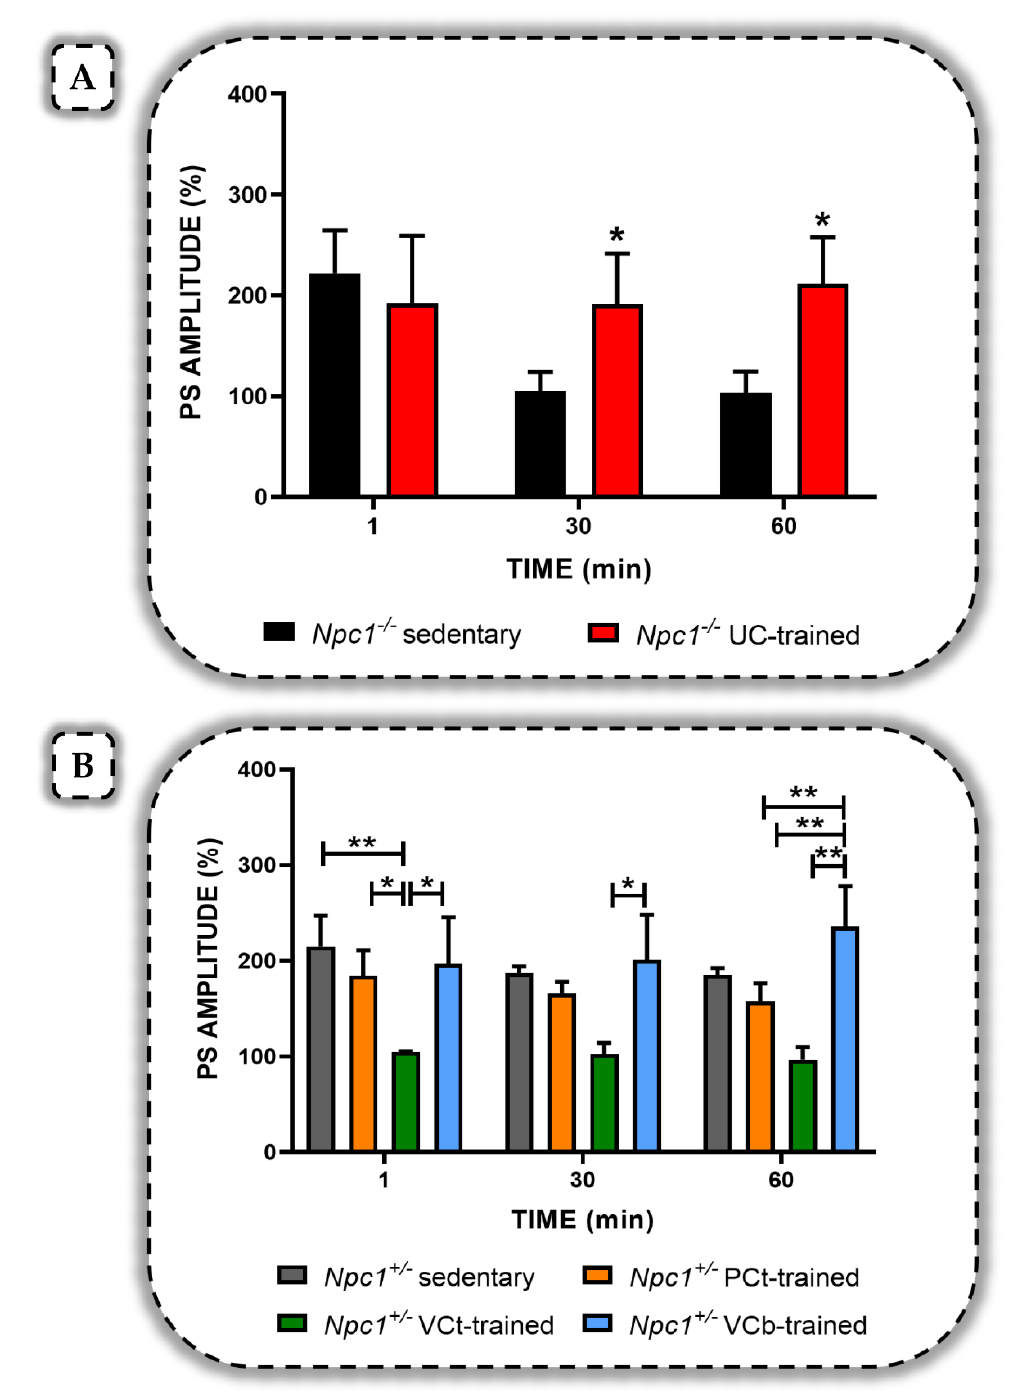
Figure 3. Effects of different aerobic exercises on synaptic plasticity in Npc1 mutant mice. ( A ) The % population spikes (PS) amplitude as a function of time after tetanic stimulation is shown in Npc1 − / − sedentary (black bar) and in Npc1 − / − UC-trained (red bar) mice slices at minutes 1, 30, and 60. Bars in the plot are means ± SEM of values obtained from different slices. The suppression of long-term potentiation (LTP), which characterized Npc1 − / − sedentary mice was completely counteracted in Npc1 − / − UC-trained mice, with significantly higher PS amplitude values at minutes 30 and 60 of recording (* p < 0.05) [121]. ( B ) The % PS amplitude as a function of time after tetanic stimulation is shown in Npc1 +/ − sedentary (grey bar), in Npc1 +/ − PCt-trained (orange bar), in Npc1 +/ − VCt-trained (green bar), and in Npc1 +/ − VCb-trained (blue bar) mice slices at minutes 1, 30 and 60. Bars in the plot are means ± SEM of values obtained from different slices. Only the VCb protocol positively modulates synaptic plasticity, since the LTP maintenance phase was characterized by higher PS amplitude values compared with those in experimental groups (** p < 0.01)